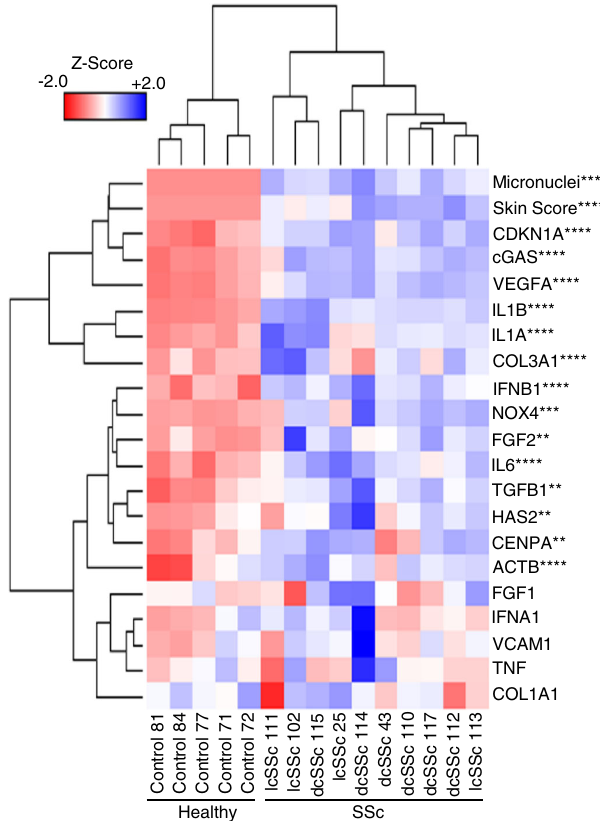
Fig. 5 | Expression of pro fi brotic, proin fl ammatory, vasculopathy, ROS, and cGAS-STING genes in fi broblasts of SSc patients. A heatmap analysis depicting gene expression content (rows) obtained by qRT-PCR in 50ng of RNA from skin fi broblasts dissected from healthy individuals and patients with lcSSc and dcSSc. Unsupervisedhierarchicalclusteringanalysiswasconductedtoascertainifdistinct genetic signatures separate healthy fi broblasts from lesion fi broblasts. Normal samples (denoted as “ control ” ) do not cluster with diseased samples, suggesting that gene expression alterations in fi broblasts obtained from SSc patients diverge from variations that occur at baseline in fi broblasts obtained from healthy indivi- duals. The number of micronuclei found per 500 nuclei count and the mRSS are included in the analysis. Data obtained in three replicates were analyzed using a multiple unpaired t -test, assuming a gaussian distribution. Stars indicate statisti- cally signi fi cant differences between the control cells and SSc patients in a t -test analysis (** p <0.1, *** p <0.001, **** p <0.0001). Source Data are provided as a Source Data fi